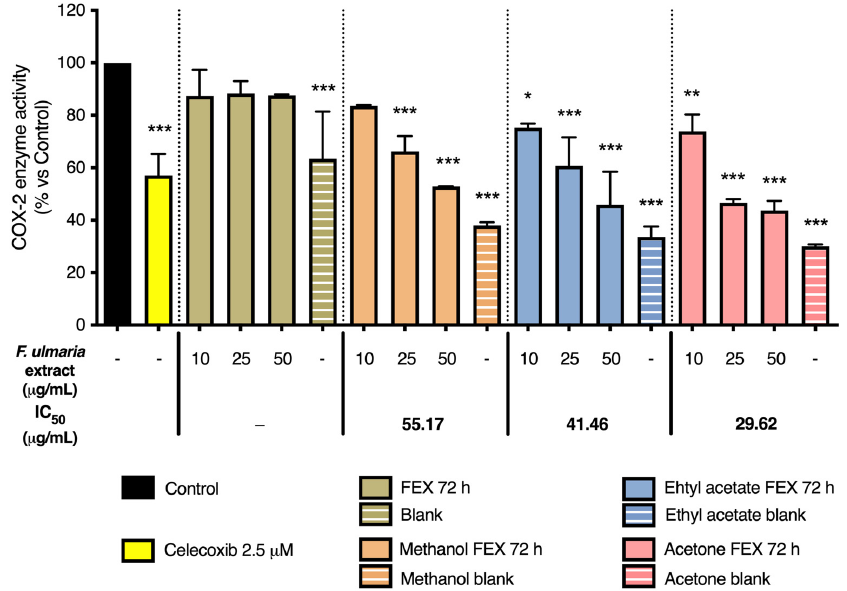
Figure 11. The effect of the digested F. ulmaria extract (FEX 72 h) and different extraction procedures of FEX 72 h on COX-2 enzyme inhibition. Celecoxib (2.5 µM), in yellow, served as positive control. The graph depicts compiled data of three independent experiments (mean ± SD). p -values are expressed as * p < 0.05, ** p < 0.01 and *** p < 0.0001 compared to control. Table 2. IC 50 of digested F. ulmaria extract on COX activity. Digested F. ulmaria Extract